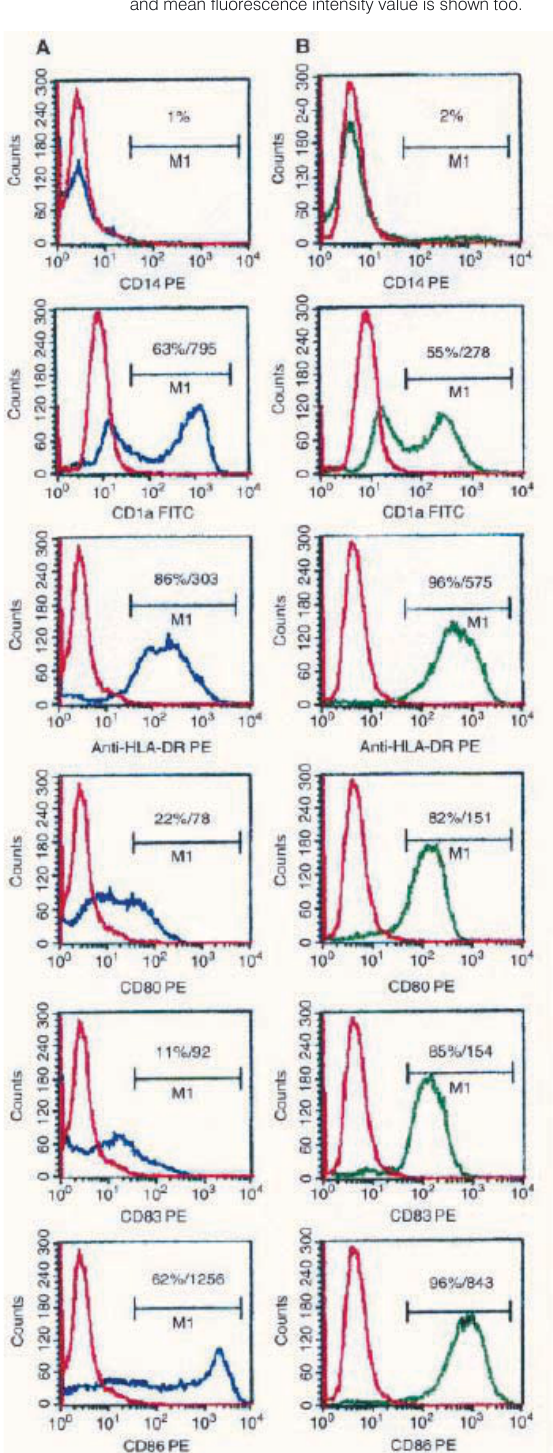
Figure 3. OImmunophenotyping profile of: A. Immature DC; B. Mature DC generated from enriched monocytes; Overlay histograms show the expression of relevant antigens of immature (blue) and mature DC (green) versus isotype- matched control (red). The percentage of positive cells and mean fluorescence intensity value is shown